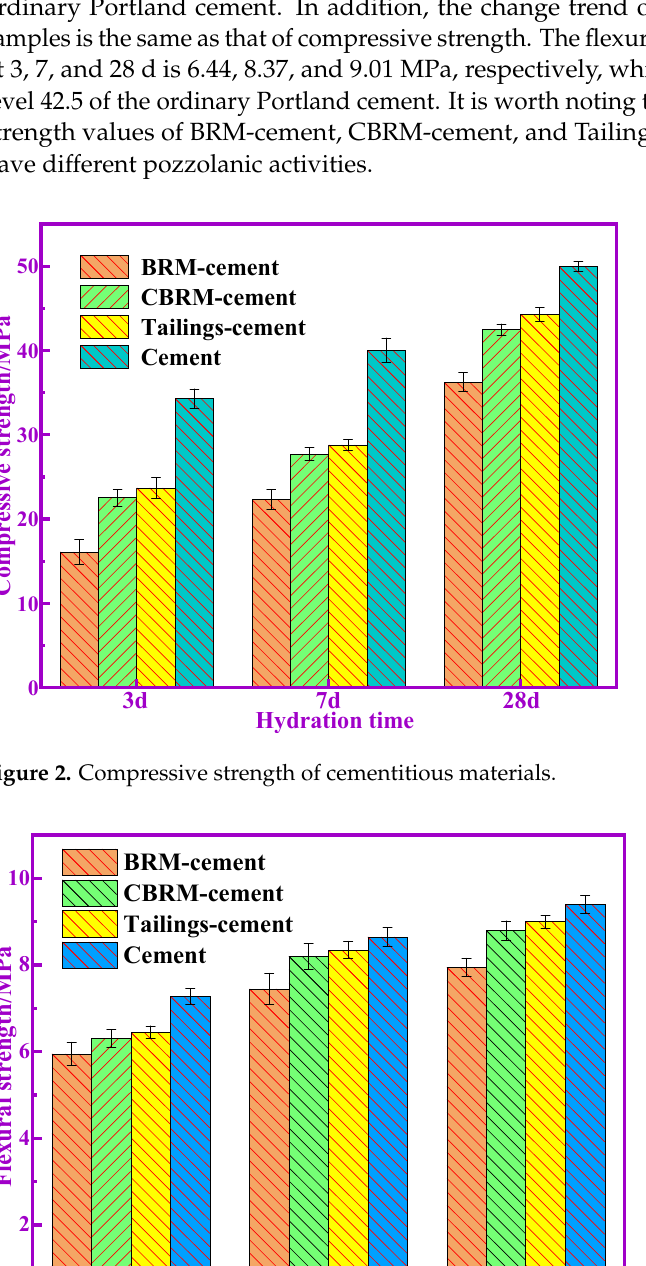
Figure 4. Pozzolanic activity index of BRM, CBRM, and Tailings. 3.2. XRD, TG, and FTIR Analysis of BRM, CBRM, and Tailings The phase composition has an important influence on the pozzolanic activity of BRM. The amorphous phase is the most active phase in BRM. Most of the crystalline components of BRM are considered to be inert and hardly participate in the hydration reaction. The XRD patterns of BRM are shown in Figure 5a. The main mineral compositions of BRM are Ca 3 Al 2 (SiO 4 )(OH) 8 (Katoite), Fe 2 O 3 (Hematite), Ca(Si 6 Al 2 )O 16 ·4H 2 O (Yugawaralite), CaCO 3 (Calcite), AlO(OH) (Diaspore), and Na 6 Ca 2 Al 6 Si 6 O 24 (CO 3 ) 2 ·2H 2 O (Cancrinite). Figure 5b shows the XRD patterns of CBRM, where the main mineral compositions of CBRM are Fe 2 O 3 (Hematite), CaAl 2 SiO 4 (OH) 4 (Chantalite), CaCO 3 (Calcite), CaAl 2 Si 2 O 7 (OH) 2 ·H 2 O (Lawsonite), CaO (Lime), and Na 6 Ca 2 Al 6 Si 6 O 24 (CO 3 ) 2 ·2H 2 O (Cancrinite). The results show that Chantalite, lime, and lawsonite are the newly formed phase, and the phase of Fe 2 O 3 remains unchanged. Compared with Figure 5a, the diffraction peak intensity of CBRM